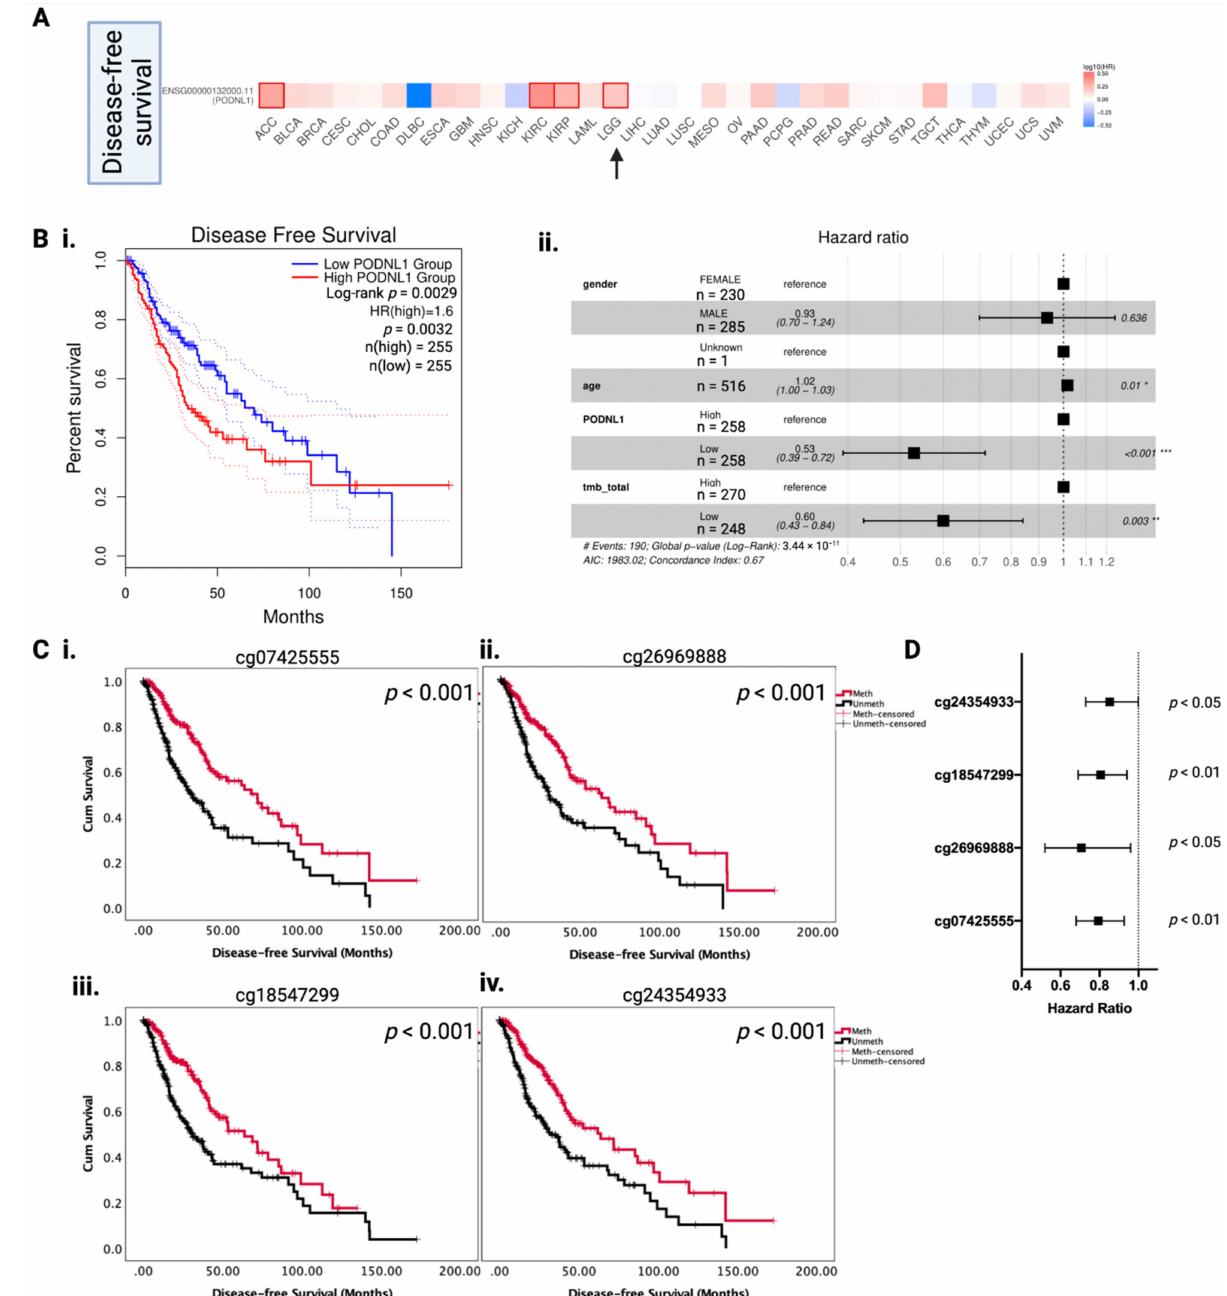
Figure 2. PODNL1 mRNA expression and methylation associates with LGG disease-free survival (DFS). ( A ) Log 10 hazard ratio heatmap showing the association between PODNL1 mRNA expression and DFS across TCGA cancers. Solid outlined border represents statistically significant prognostic effects ( p < 0.05). Lower-grade glioma (LGG) is indicated with a black arrow. ( B ) ( i ). Kaplan–Meier survival curve showing DFS based on PODNL1 mRNA levels (median expression cut-off). The curves show 95% confidence intervals for each group in dotted lines. ( ii ). Forest plot showing multivariate hazard ratio based on gender, age, tumor mutational burden (TMB), and PODNL1 mRNA expression groups (median expression cut-off) for TCGA-LGG. *** p < 0.001, ** p < 0.01 and * p < 0.05. ( C ) ( i – iv ). Kaplan–Meier survival curves (DFS) based on methylation levels (median beta value cut-off) of four PODNL1 CpGs. The red line indicates “Meth” or the high methylation group and the black line indicates “Unmeth” or the low methylation group. Sample numbers n = 254 for each methylation group, for all figures. Log-rank p -values are marked in each figure. A p -value of <0.05 was considered significant. ( D ) Forest plot of DFS multivariate analysis hazard ratios for each significant CpG, after adjusting for age, gender, tumor grade, and IDH1